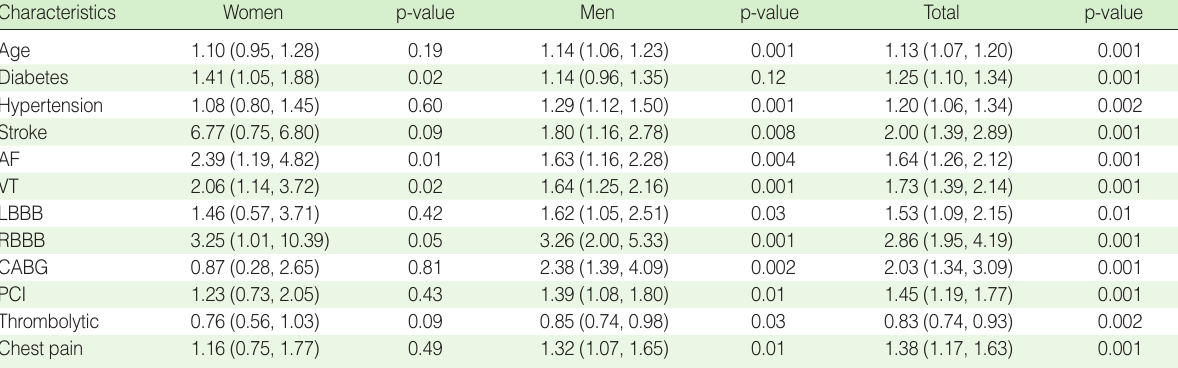
Table 4. Adjusted odds ratio for risk factors for heart failure in men and women myocardial infarction patients